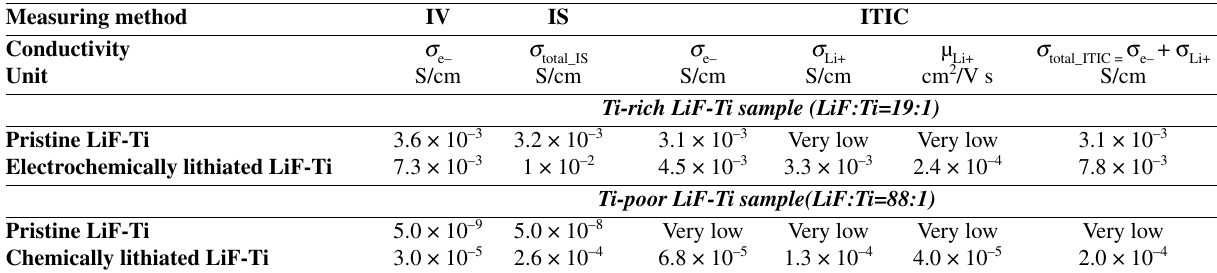
Table 2. RT conductivity of the LiF-Ti nanocomposite before and after electrochemical and chemical lithiation (measured by IV, IS and ITIC). Measuring method IV